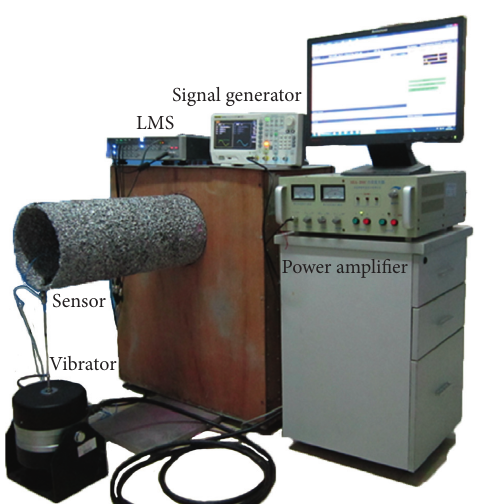
Figure 2: Vibration experiment of a porous cylinder at the bottom of the free end ( θ � 0 ) . The deflections of the bottom and top points at the free end are both measured. The